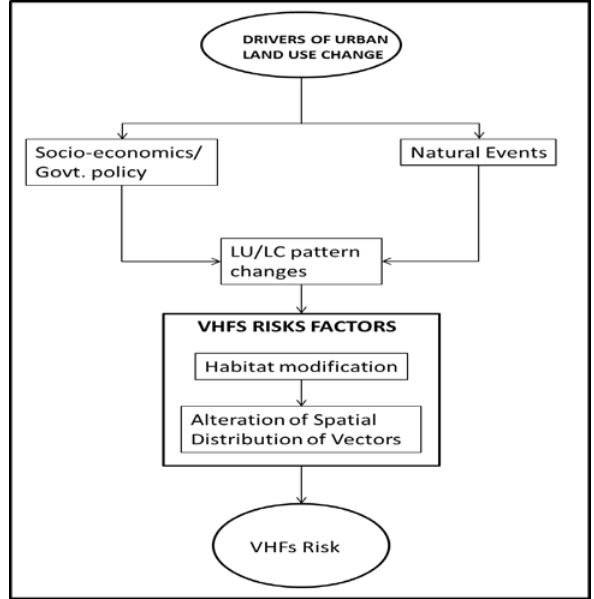
Figure 1: A relationship framework interfacing urban land use pattern changes with the VHFs